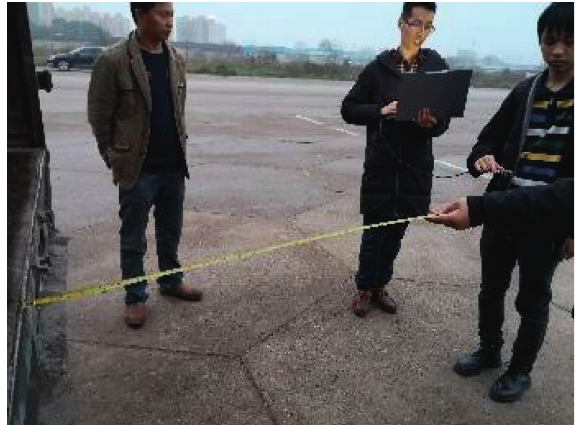
Figure 13: A value measurement process. Figure 14: Illegal detection test.